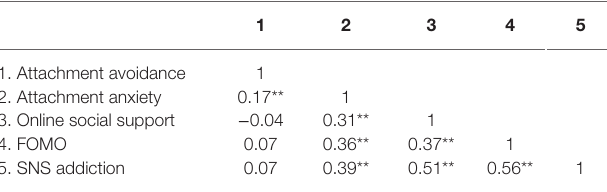
TABLE 1 | Descriptive statistics and results of correlational analysis of variables ( N = 463).